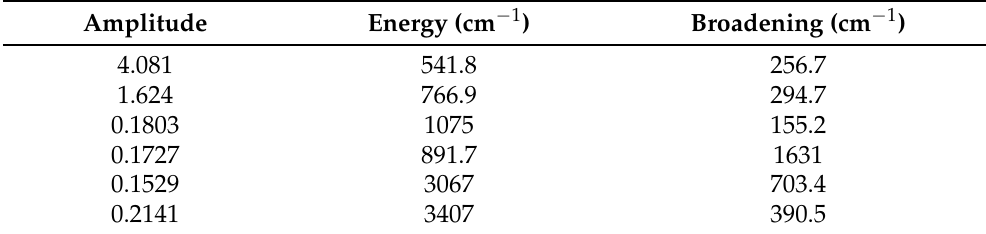
Figure 2. Real ε 1 ( λ ) and imaginary ε 2 ( λ ) part of the model dielectric function of amorphous Al 2 O 3 in the spectral range of 2 µm to 33 µm used for the COMSOL calculations reported here. The model dielectric function is composed of six Gaussian oscillators with the parameters summarized in Table 1. Table 1. Amplitude, center energy, and broadening parameters of the six Gaussian oscillators used to characterize amorphous Al 2 O 3 in the wavelength range from 2 µm to 33